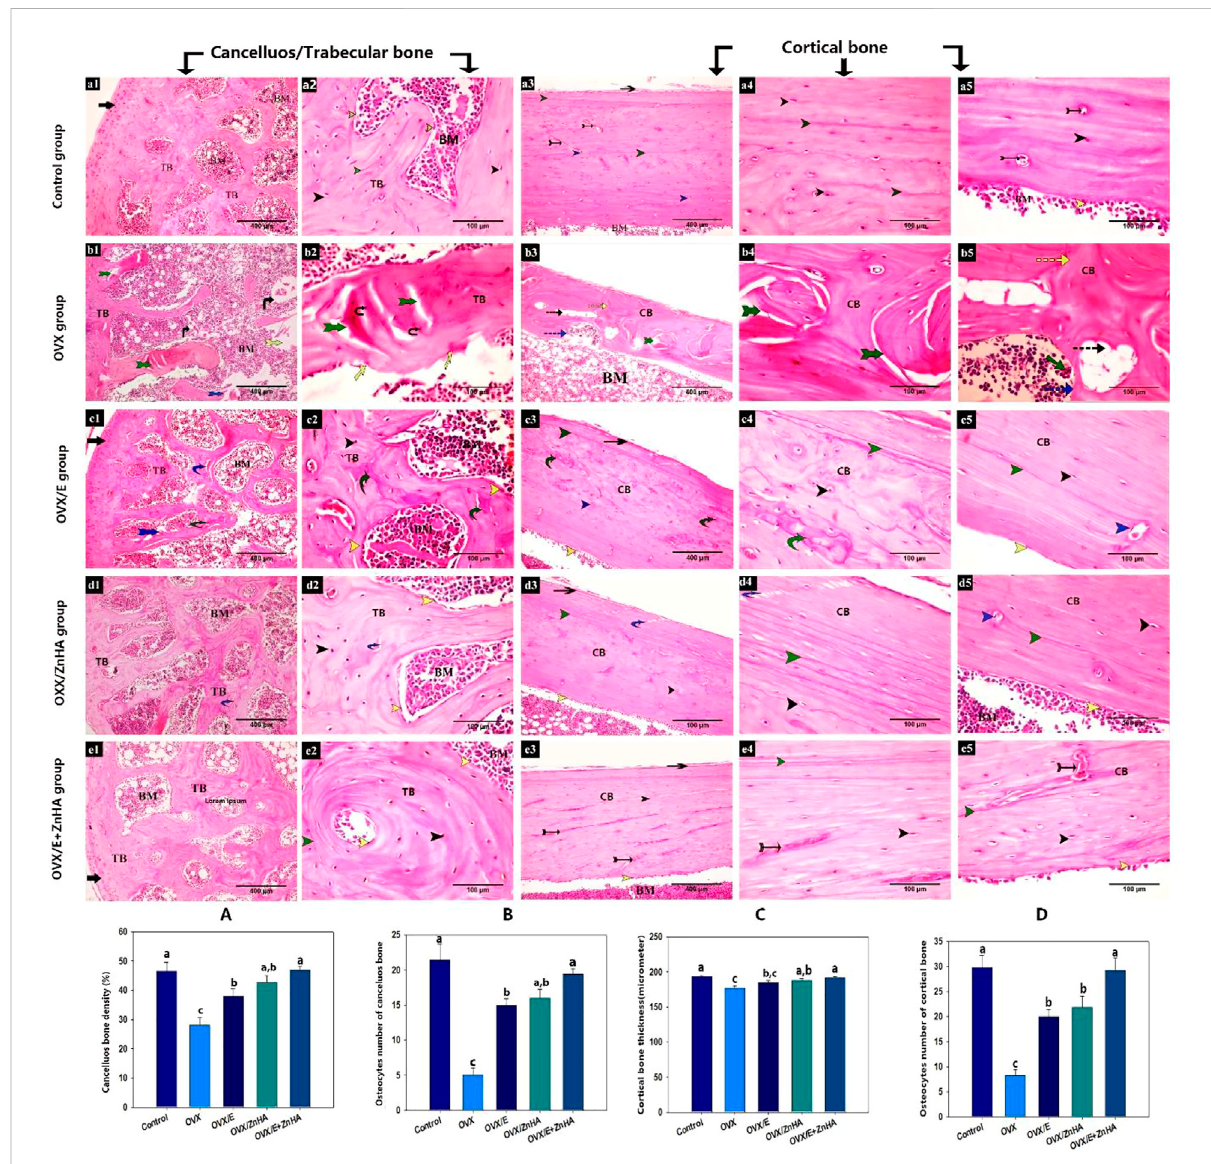
FIGURE 5 Photomicrograph of the bone tissue stained with H & E following estrogen (E2) and/or zinc hydroxyapatite nanoparticles (ZnHA-NPs) in ovariectomized(OVX)ratsshowing:articularcartilage(blackarrow),anastomosingandthickbonetrabeculae(TB),bonemarrowcavity(BM),cortical bone (CB), lacunae containing osteocytes (black arrow head), distinct cement lines (green arrow head), smooth, continuous endosteal surface with osteogenic and osteoblast cells(yellow arrow head), Haversian canal (blue arrow head), blood vessel (tailed black arrow), overlying periosteum (blue arrow), thin bone trabeculae (tTB), distorted and cracked bone trabeculae (tailed green arrow), necrotic osteocytes (black tailed arrow), bone spiculeisland(s),distortedareaofbonemarrow(yellowtailedarrow),erodedendostealsurfacewithosteoblastabsence(yellowarrow),corticalbone with disorganized bone matrix (discontinues green arrow) or with many resorption vacuoles (discontinuous black arrow), how ship ’ s (discontinues blue arrow) containing osteoclasts (green arrow). Note that some cracks (curved blue arrow) were detected in bones from OVX/E2 and OVX/ZnHA ratsoramosaicbonymatrixappearance(curvedgreenarrow)anddiscontinuouscementlines(redarrowhead)weredetectedinbonefromOVX/E2 rats.(a1,2)trabecularbone(a3-5)corticalboneofcontrolgroup.(b1,2)trabecularbone(b3-5)corticalboneofOVXgroup.(c1,2)trabecularbone(c3- 5)corticalboneofOVX/Egroup. (d1,2)trabecularbone (d3-5)cortical bone ofOVX/ZnHA group. (e1,2)trabecularbone(e3-5) cortical bone ofOVX/ E+ZnHA group. Histomorphometric analysis (A-D) were expressed as mean ± SME ( n = 5/group, triplicate). Bars carrying different superscripts are signi fi cantly different ( p <